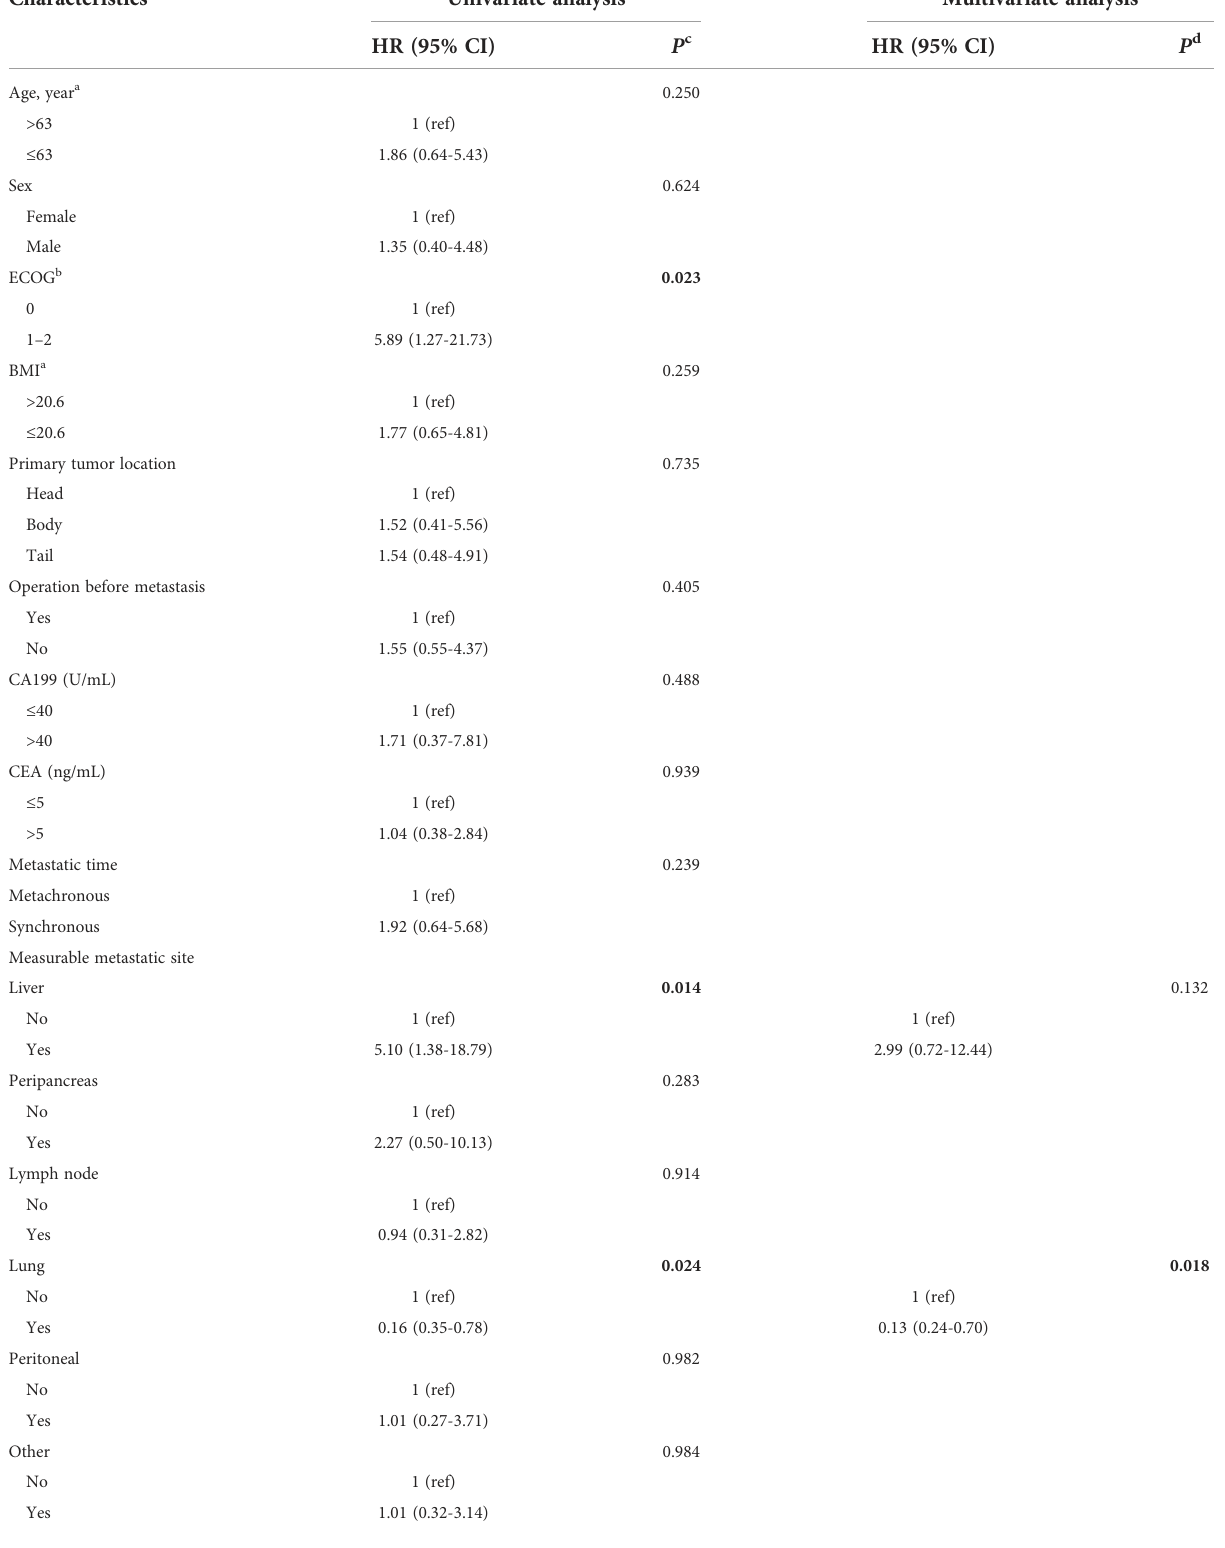
TABLE 5 Univariate and multivariate analyses of clinicopathological data and in fl ammatory markers in